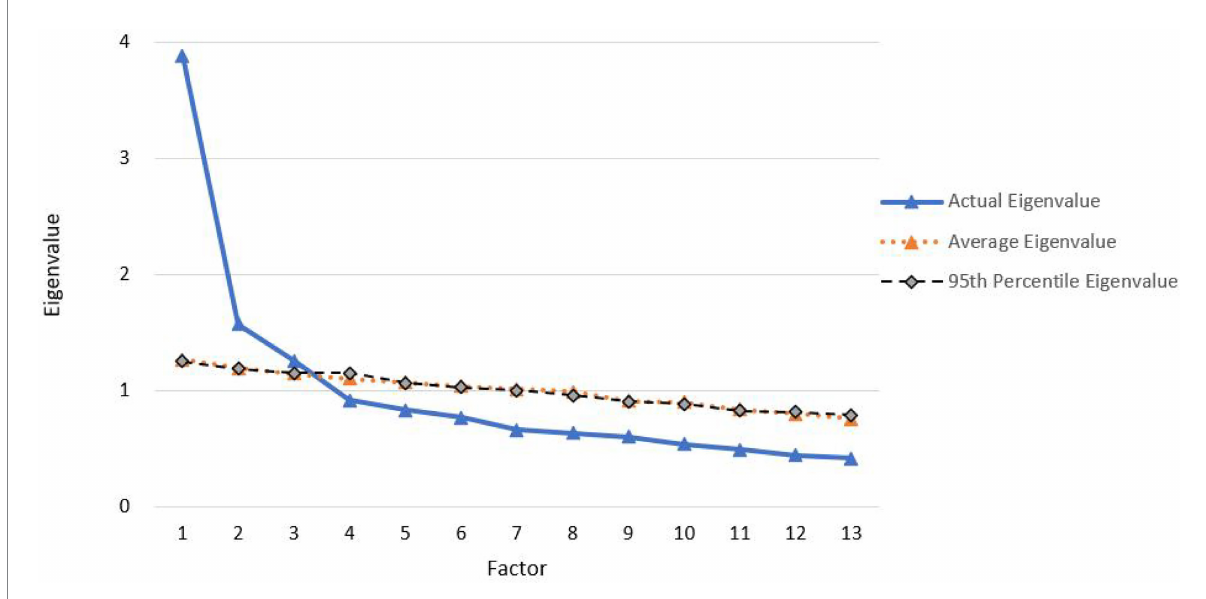
FIGURE 1 Parallel analysis of SCLS. SCLS, Scale of Student Conceptual